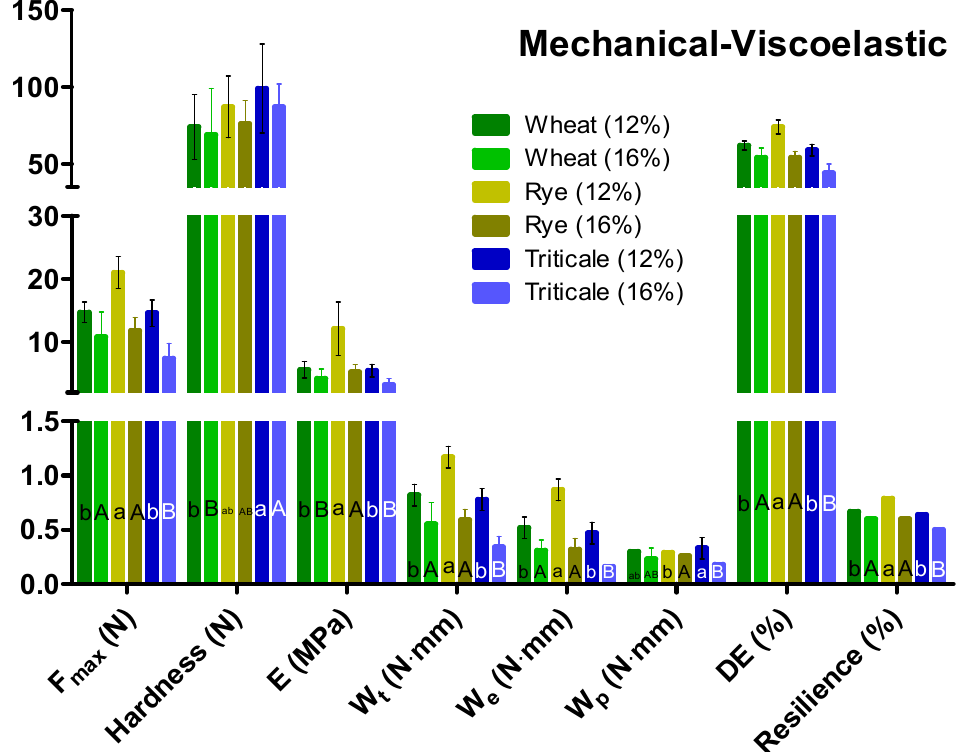
Figure 2. Mean ± standard deviation of the mechanical properties and viscoelastic performance of wheat, rye, and triticale kernels at different moisture contents. F max : maximum force; E : elastic modulus; W t : total work; W e : elastic work; W p : plastic work; DE : degree of elasticity. Mean values for the same cereal type with different letters (lowercase and uppercase) were statistically different ( p < 0.05) at the different moisture contents (12% and 16%, respectively).